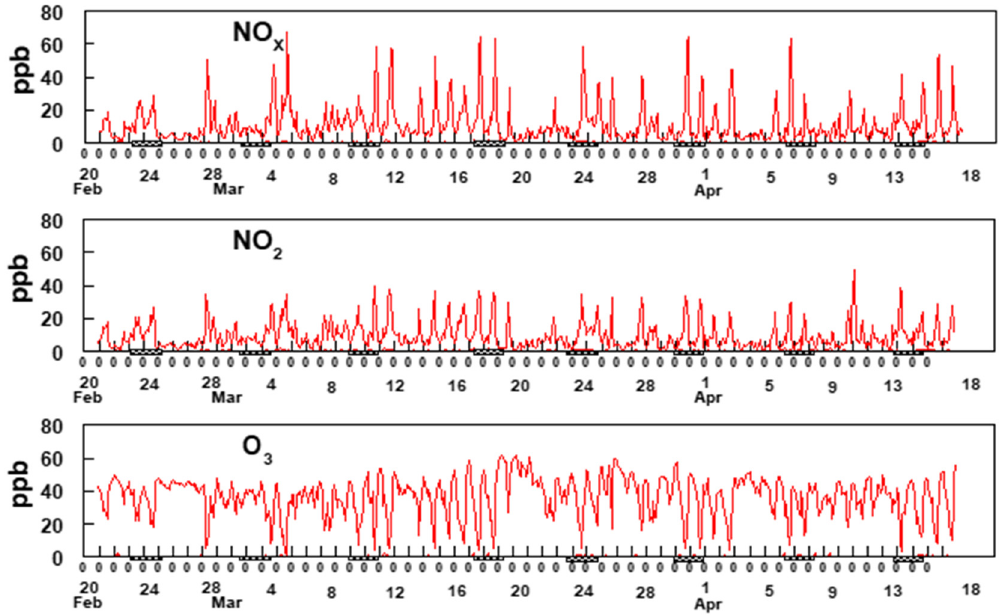
Figure 8. Two-hour average data for NO x , NO 2 , and O 3 . The hash marks under the x -axis indicates weekends .